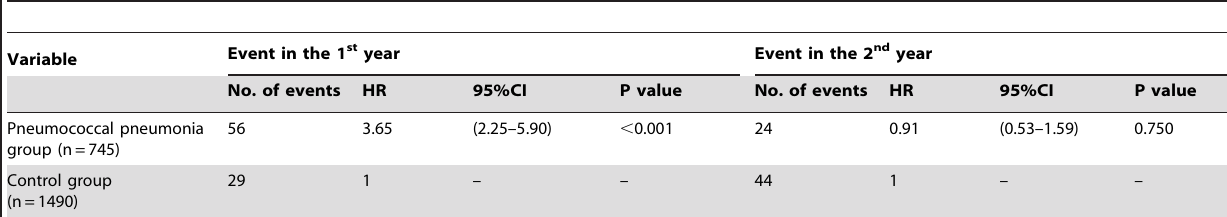
Table 4. Hazard ratio of stroke among the pneumococcal pneumonia patients and the control group stratified by time; 85 stroke events in the first year of follow-up and 68 events in the second year of